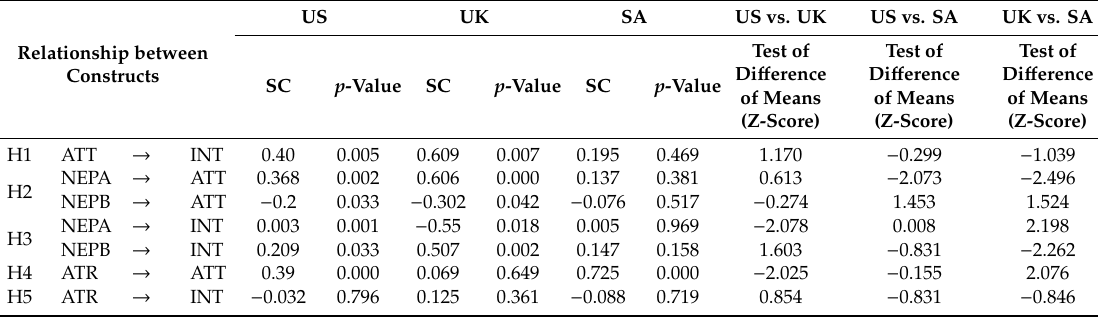
Table 8. Statistical di ff erences in the relationships between